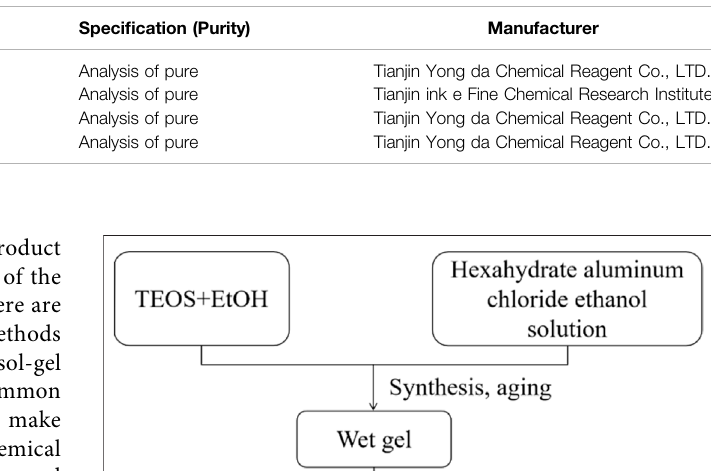
TABLE 1 | Main chemical reagent.